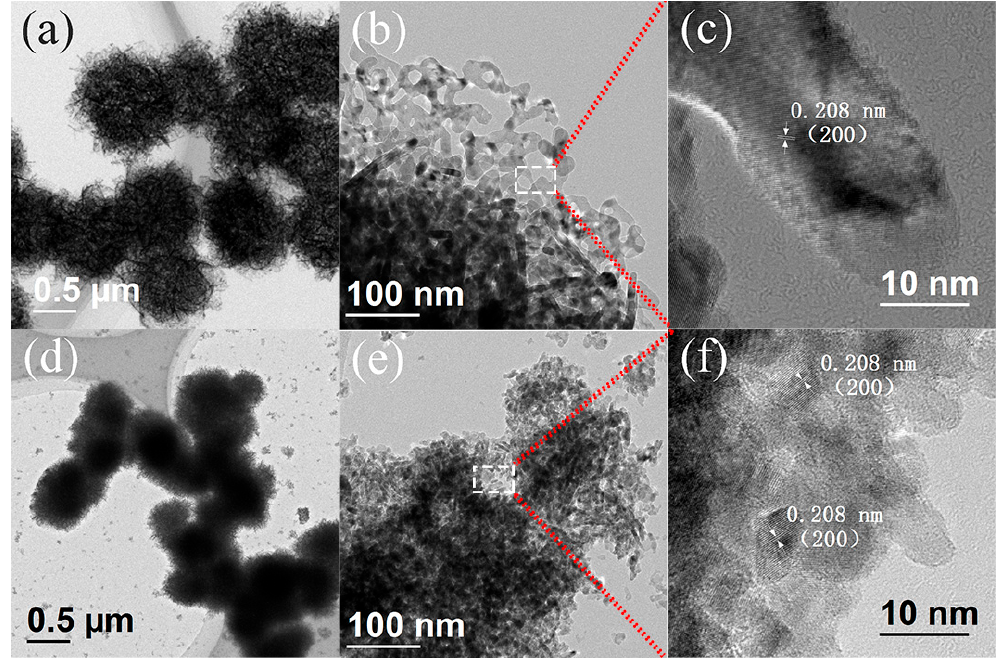
Figure 4. ( a , b ) Typical TEM and ( c ) HRTEM images of NiO sample; ( d , e ) Typical TEM and ( f ) HRTEM images of the SNM-8 sample.